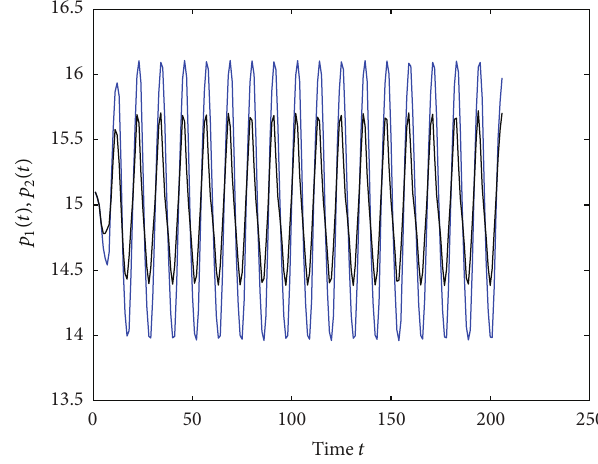
Figure 7: (𝑡,𝑝 1 (𝑡)) and (𝑡,𝑝 2 (𝑡)) , for 𝜏 < 𝜏 0 .